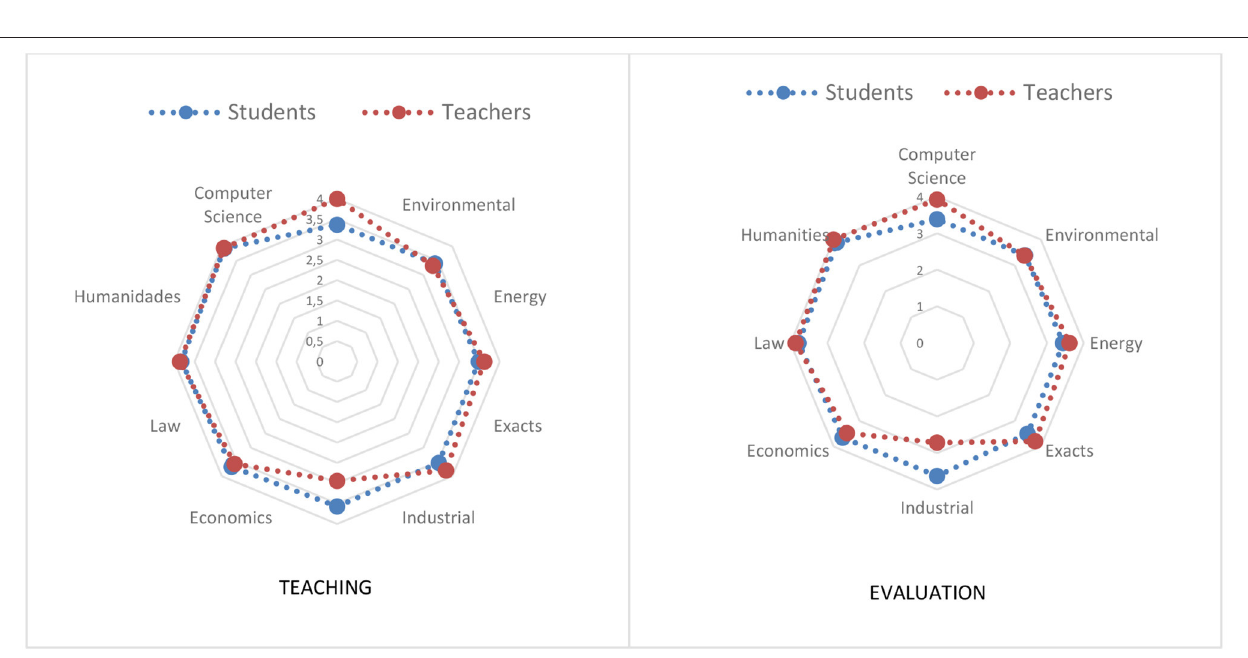
FIGURE 3 | Teaching and evaluation of ARC through an argumentative text.